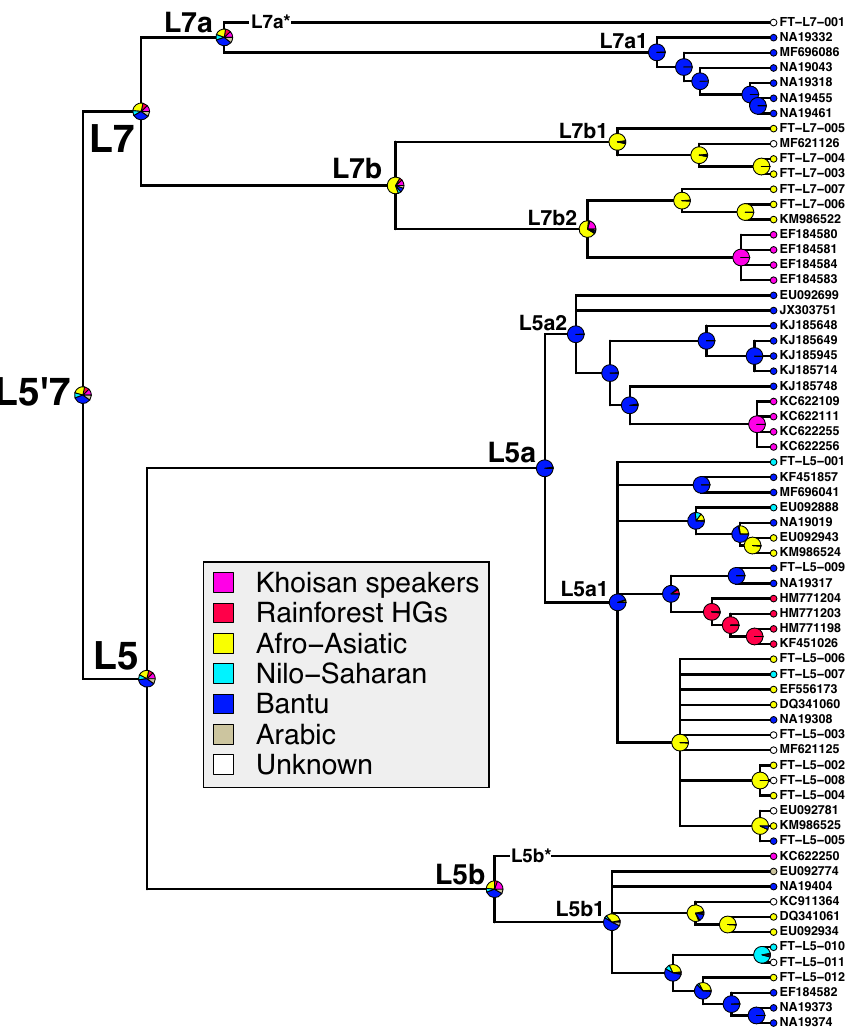
Figure 5. Ancestral Reconstruction of Population Groups. Major population groupings for each sequence are shown as small colored circles at the tips of the tree. Each ancestral pie chart represents the likelihood that node derives from each